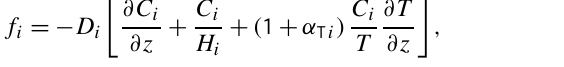
Figure 3. Average values of δ (O 2 /N 2 ) and the CO 2 mole fraction observed above 18-25 2 Fig. 3. Average values of δ (O 2 /N 2 ) and the CO 2 mole fraction ob- km over Sanriku and Taiki, Japan for the period 1999-2010, after (black open circles) and 3 served above 18–25km over Sanriku and Taiki, Japan, for the pe- before (red triangles) correcting for the gravitational separation effect. Asterisks denote 4 the annual mean values of δ (O 2 /N 2 ) and the CO 2 mole fraction observed in the upper 5 riod 1999–2010, after (black open circles) and before (red trian- troposphere over Japan for the period 2000-2010. 6 gles) correcting for the gravitational separation effect. Asterisks de- 7 note the annual mean values of δ (O 2 /N 2 ) and the CO 2 mole frac- tion observed in the upper troposphere over Japan for the period